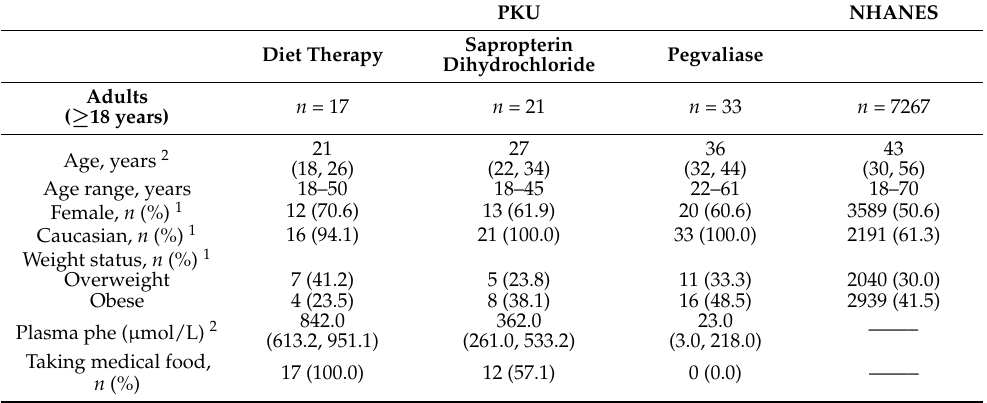
Table 1. Characteristics of the NHANES ( n = 10,681) and PKU ( n = 120) Study Populations, by Age and Treatment